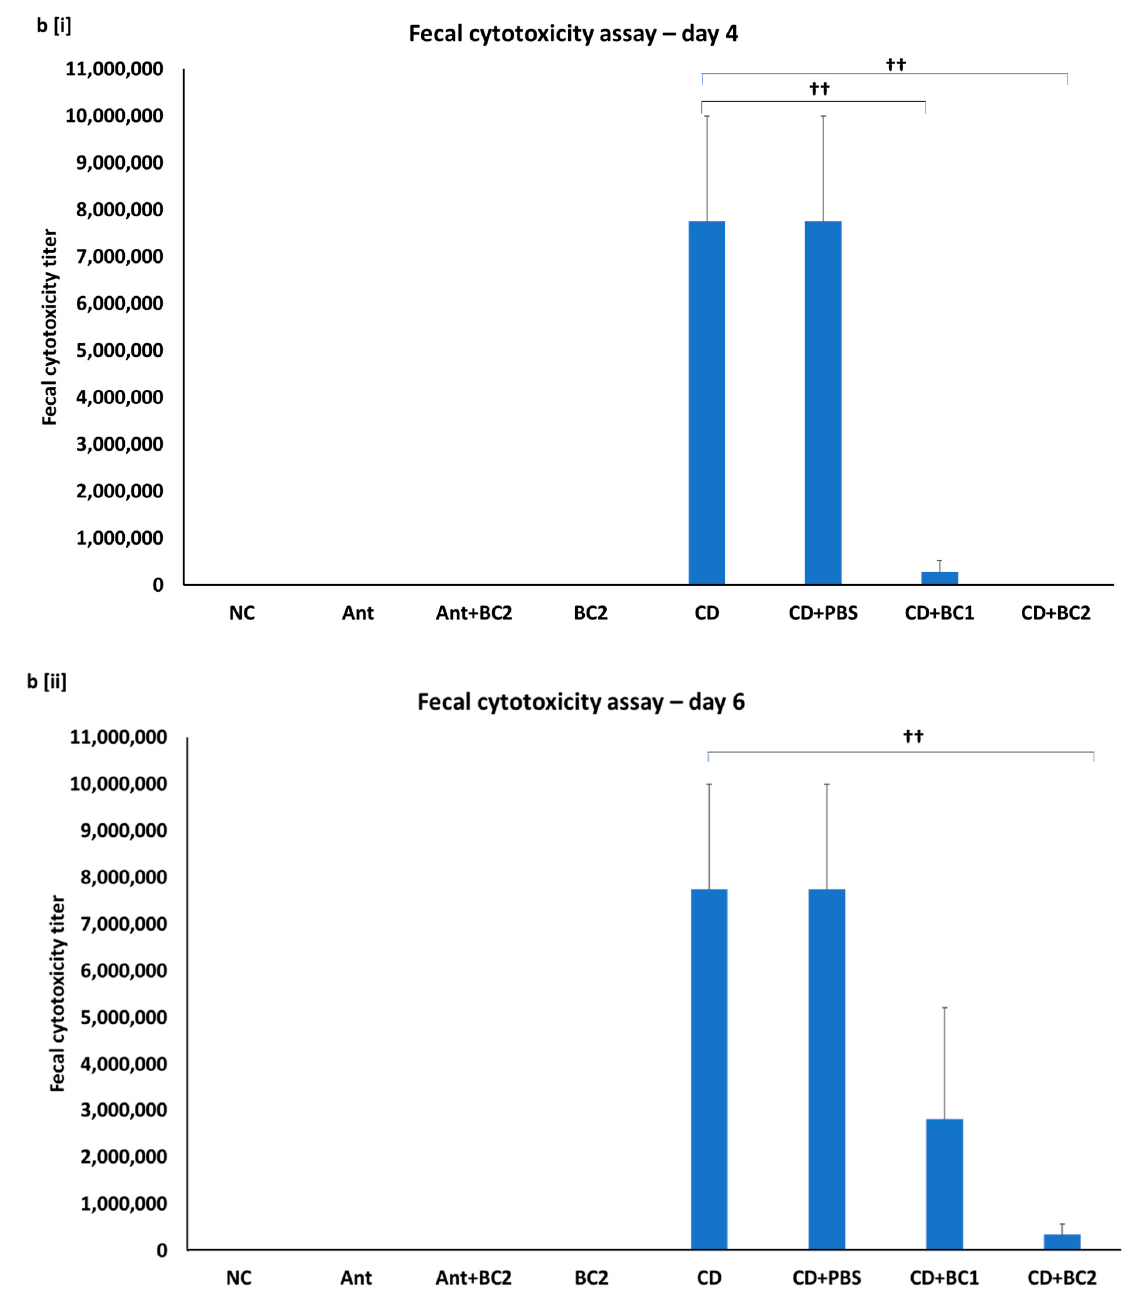
Figure 5. Effect of prophylactic baicalin supplementation on C. difficile counts and Vero cell cytotoxicity using fecal slurry supernatants. ( a ) Enumeration of C. difficile from fecal samples using (i) qPCR-based quantification using fecal DNA (5 ng content) from day 2 post infection, and ( a (ii,iii)) serial dilution and plating of fecal samples on cycloserine-cefoxitin fructose containing 0.1% sodium taurocholate (CCFA-T) agar plates from day 4 and 6 post infection. ( b (i,ii)) Fecal cytotoxicity assay using fecal samples collected during day 4 and 6 of the prophylactic study. Error bars represent SEM. ††, † symbol indicates a statistically significant difference ( p < 0.001, p < 0.05, respectively) relative to challenged positive control (CD) vs. the baicalin-treated challenged mice (CD+BC1 or CD+BC2).